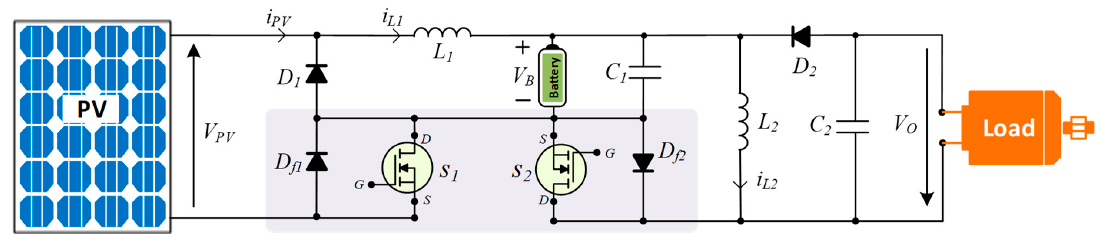
Figure 4. The modified and electrically equivalent circuit from Figure 2. The added diodes ( D f1 and D f2 ) do not modify its operation.